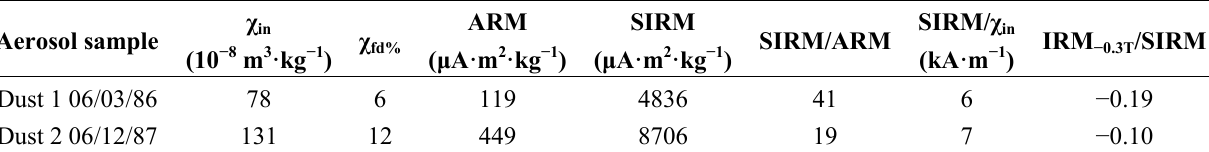
Table 3. Magnetic characterization of aerosol samples collected over the island of Corsica. Aerosol